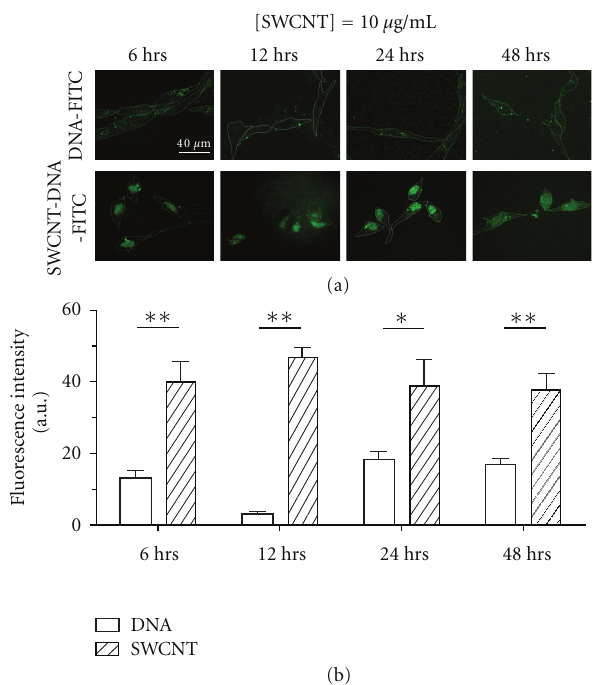
Figure 3: Intracellular compartmentalization and fluorescence intensity of SWCNT-DNA-FITC (10 µ g/mL) and DNA-FITC (10 µ g/mL) in microvascular ECs and observed at 6, 12, 24, and 48hrs. (a) Representative projection images acquired by confocal microscopy; (b) Quantitative analysis of fluorescence intensity of SWCNT-DNA-FITC and DNA-FITC conjugates. The P -values less than 0.05 and 0.01 are expressed as ∗ and ∗∗ , respectively ( n = 3– 12). The scale bar is applicable to all